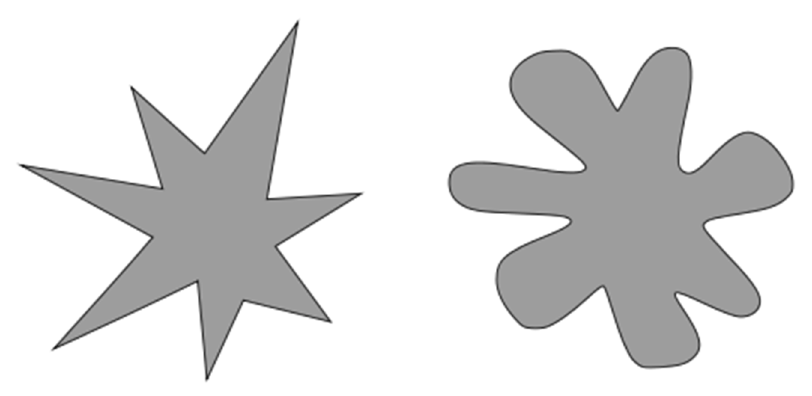
Figure 1. Kiki and Figure 1. Kiki and bouba.